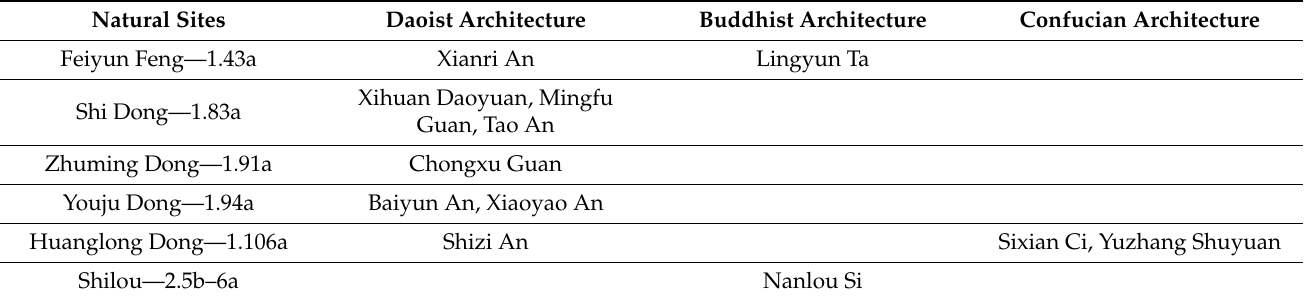
Figure 4. Panorama of the Luofu Mountains in Yesheng , marked with Daoist (blue) and Buddhist (red) sites. Image edited by the author. Table 3. Religious Architecture Depicted in Illustrations of Han Mingluan’s Luofu zhilue